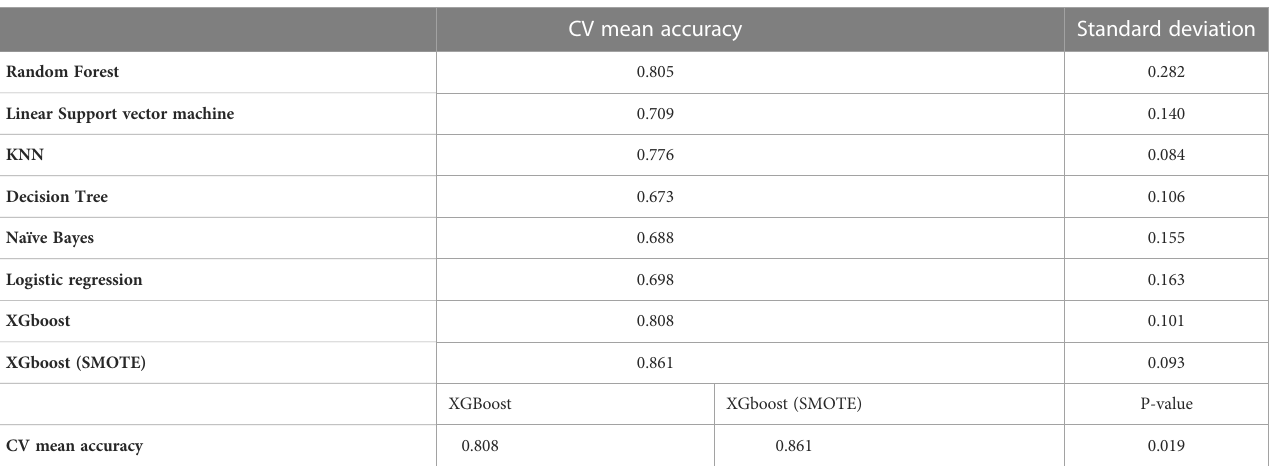
TABLE 3 Performance of